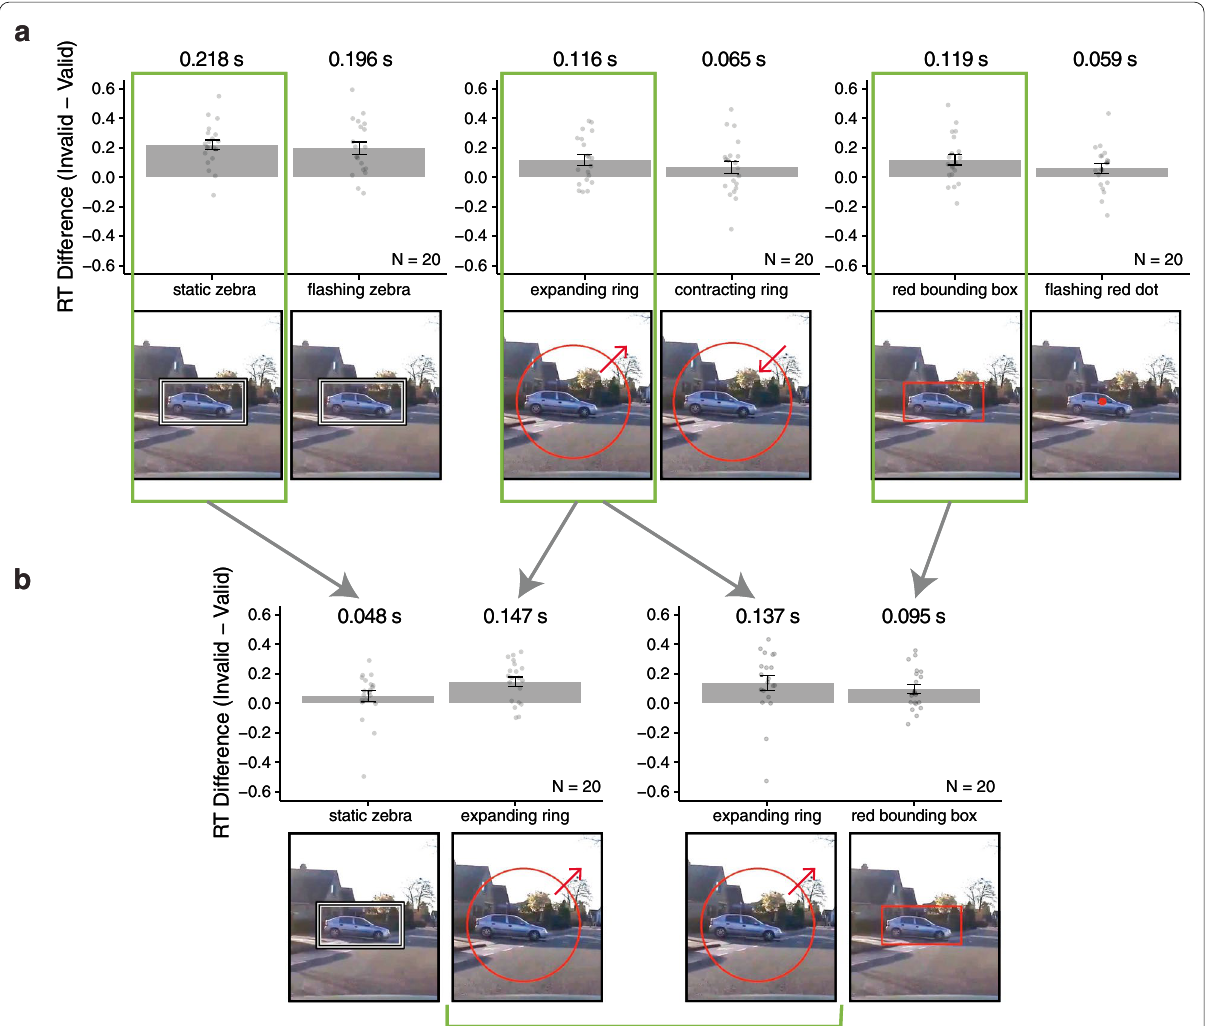
Fig. 2 Diagram of the set of five cue selection experiments used to evaluate different cue types. There were 100 participants in total ( n 20 = per cue selection experiment); each pair of bars represents one experiment, each with a different group of participants. The y -axis on each bar graph indicates the difference in reaction time (in seconds) between the invalid and valid cue conditions, with positive values indicating slower reaction times in the invalid cue condition. Note that in the main experiment, the RT difference between valid and invalid spatiotemporal cues was approximately 120 ms. Error bars indicate 1 SEM. a The first set of three experiments measured the cue validity effect for the static versus ± flashing zebra cues, the expanding versus contracting rings, and the red bounding box versus flashing red dot. b The three cue types with the larger RT difference within each paired comparison (the static zebra, the expanding ring, and the red bounding box) were used in two additional paired comparisons: static zebra versus expanding ring and expanding ring versus red bounding box. In all 5 experiments, all pairwise differences between cue types conditions were not statistically significant, but the cue with the largest invalid-to-valid RT difference within the second set of experiments—the expanding ring—was chosen for the main